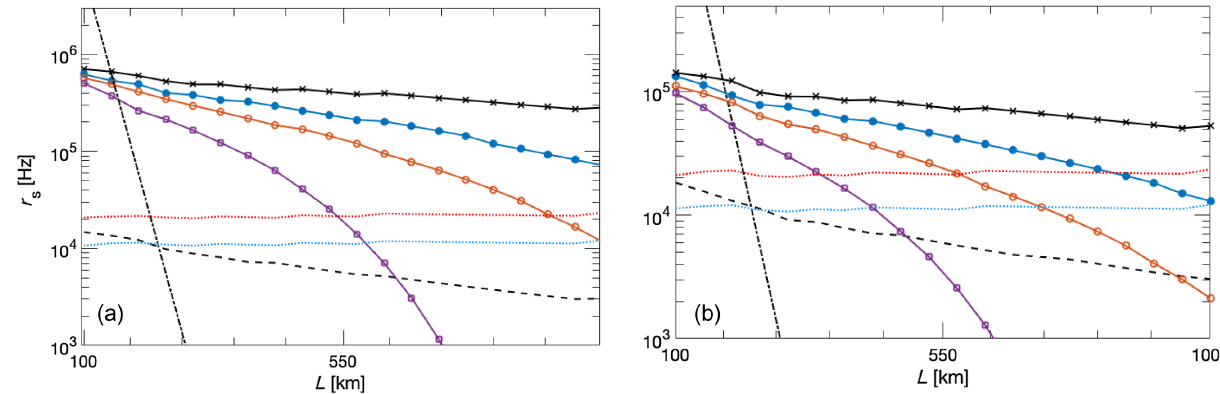
FIG. 1. Reproduction of Figs. 6(c) and 6(d) from the main article, with corrected simulations of the two-way repeater added. Panel (a) corresponds to Fig. 6(c) and panel (b) to Fig. 6(d) of the article. The black dashed line is the published erroneous rate of the generic two- way repeater, while the red dashed lines show the result of the corrected rate optimization. The blue dashed lines show the result of an optimization, where the total number of qubits is kept strictly the same or lower than the total number of spin qubits for the one-way repeater for the same distance. The specifics of the other curves correspond to those of Figs. 6(c) and 6(d) in the article. The secret bit rate ¼ 1 ns and gate time of τ ¼ 10 ns, is shown in panel (a), while for a gate of the tree repeater, assuming a photon emission time of τ ph CZ ¼ 100 ns, it is shown in panel (b). The markers correspond to the following: × ∶ ϵ ¼ 0 . 1 ‰ , : ϵ ¼ 0 . 3 ‰ , : ϵ ¼ 0 . 5 ‰ , time of τ r r r CZ and : ϵ r ¼ 0 . 1% . Here, ϵ r is the error probability of the re-encoding operation at the repeater stations. In comparison, we have assumed the generic two-way repeater to be error-free. We have restricted the minimization to trees with n ≤ 300 photons and repeater station spacings greater than or equal to 1 km. We have assumed a detection efficiency of η d ¼ 95% . For comparison, the secret bit rate of direct transmission (dot-dashed line) is shown, assuming a 1-GHz single-photon source.